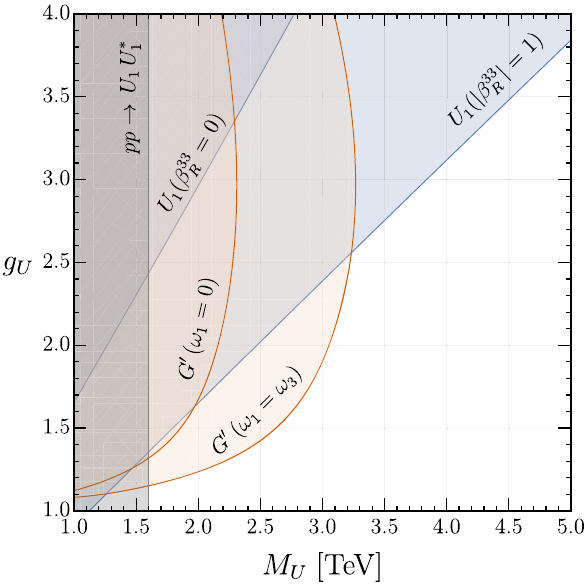
Fig. 11 Leading 95% CL exclusion limits for the U 1 and the col- oron, shown in the ( g U , M U ) plane assuming the relation between their masses and couplings following from the gauge symmetry in (6) and the breaking pattern assumed in [15,18]. See text for more